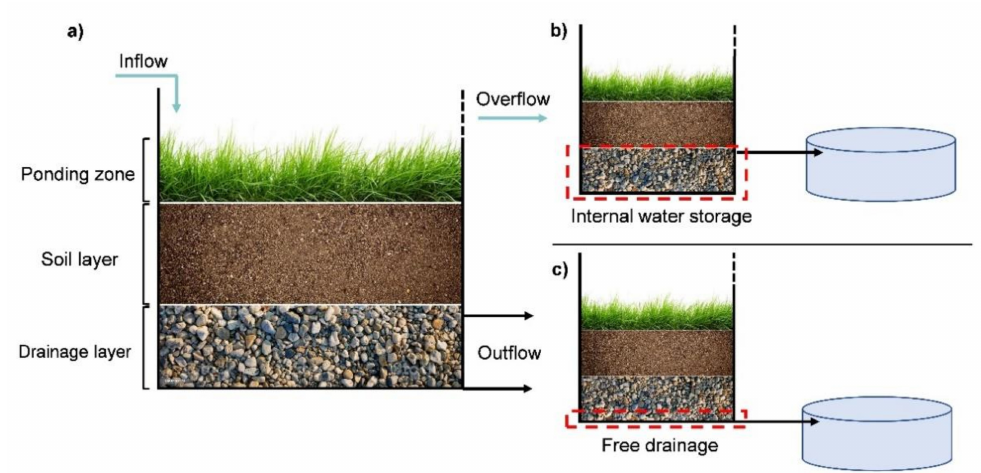
Figure 2. Standard bioretention designs. ( a ) Typical bioretention structure with three layers. At ( b ) a stormwater harvesting reservoir is added at a height that allows the creation of an internal water storage (IWS). ( c ) represents a free drainage (FD) bioretention. In both cases, the stormwater harvesting reservoir is optional; however, it adds more possibilities for